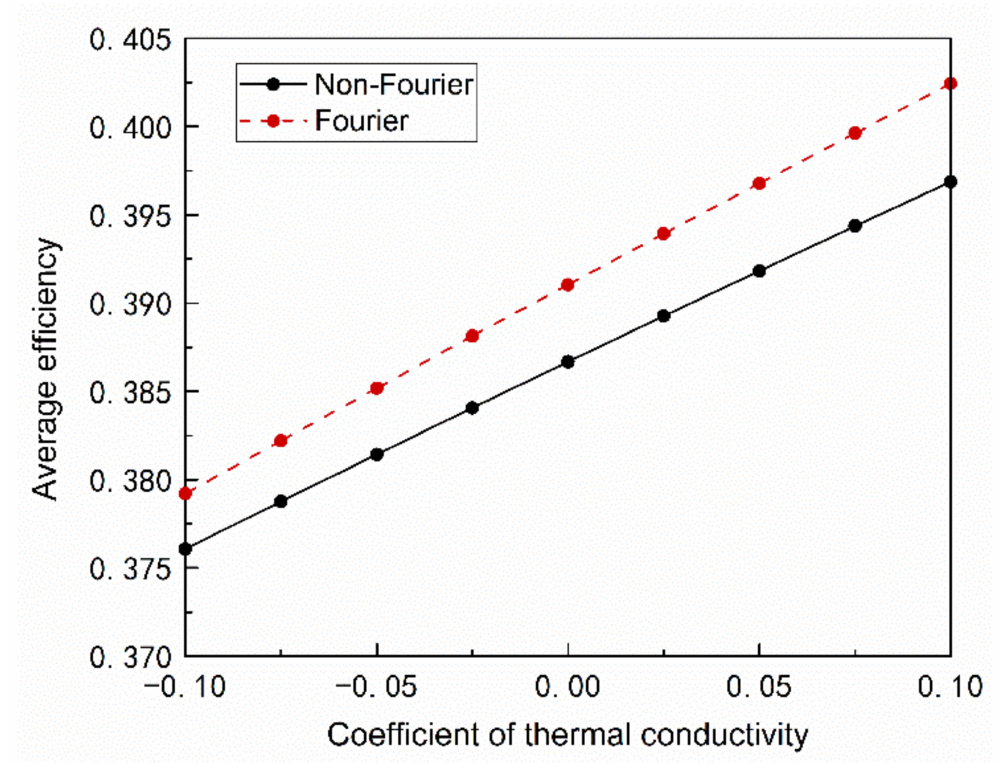
Figure 12. The variation of average fin efficiency with different values of µ